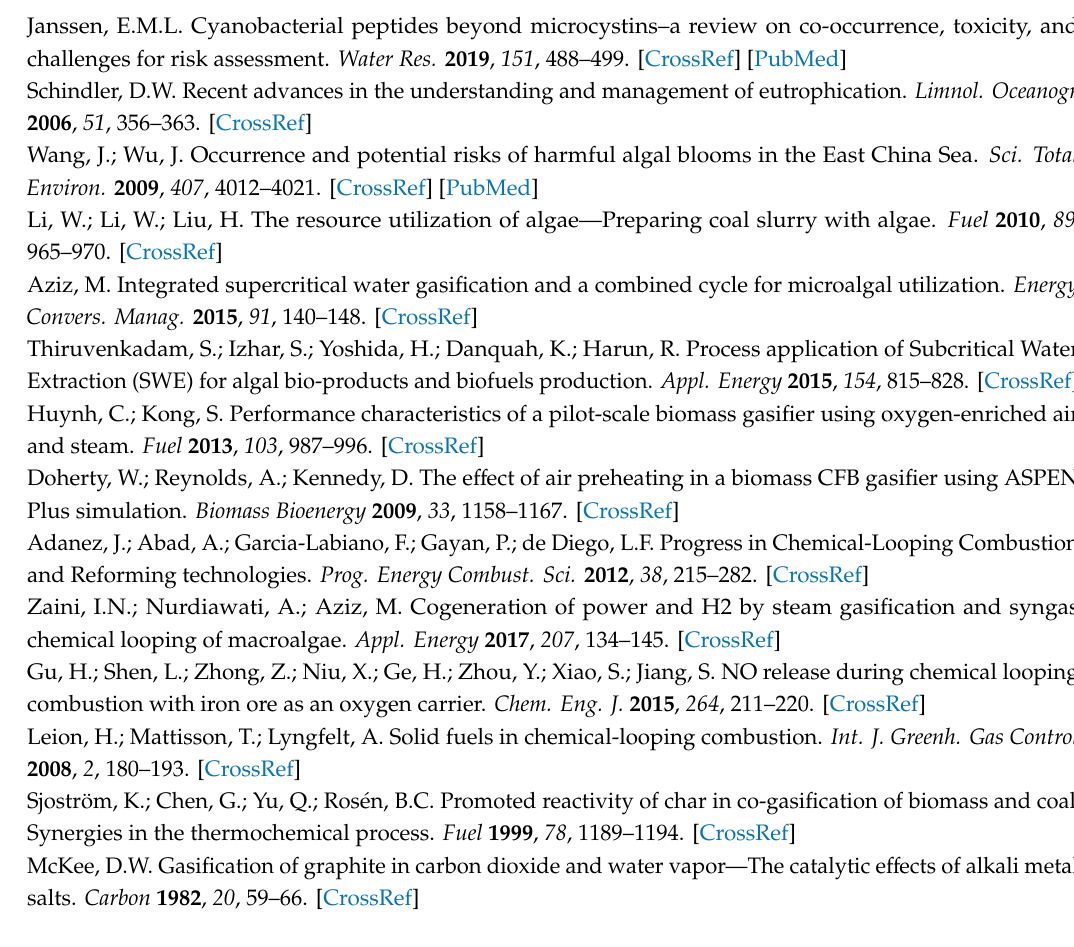
Figure S1: The repeated TGA experiment of the mixture fuel with 82 wt.% cyanobacteria and 18 wt.% coal (82CYA sample), Figure S2: The carbon balance as a function of the cyanobacteria blending